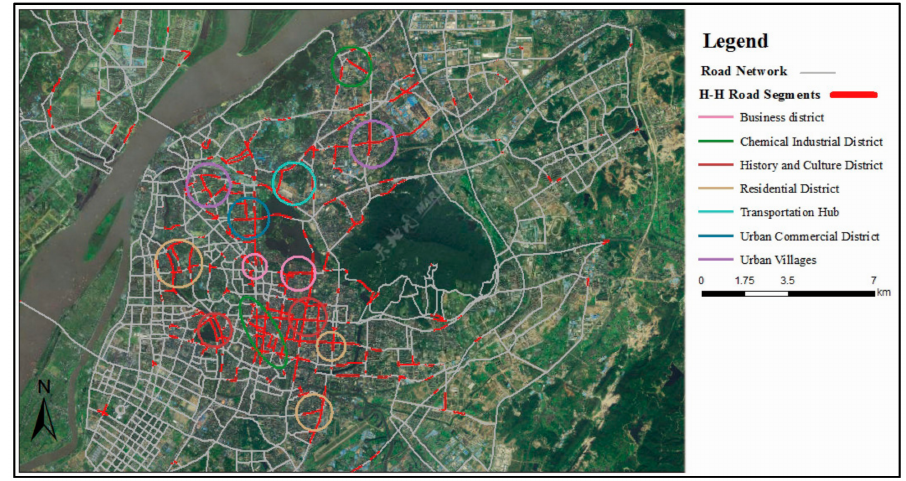
Figure 15. Six fire higher-risk regions of Nanjing in a network space.